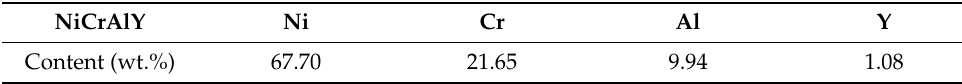
Table 1. Composition and contents of NiCrAlY powders.